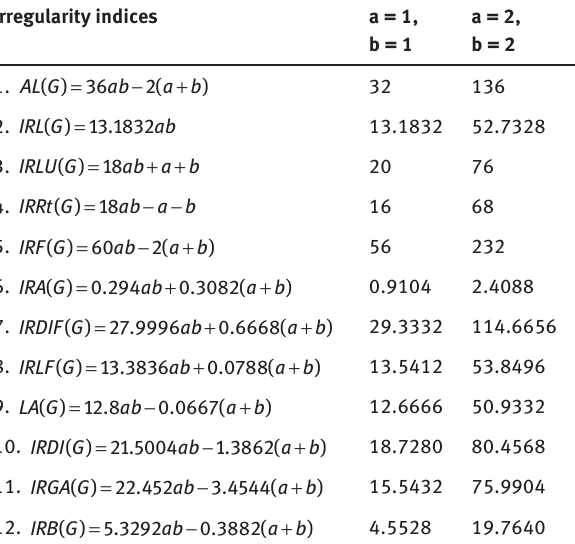
Table 4: Irregularity indices of 2D CoBHT(CO) lattice Irregularity indices